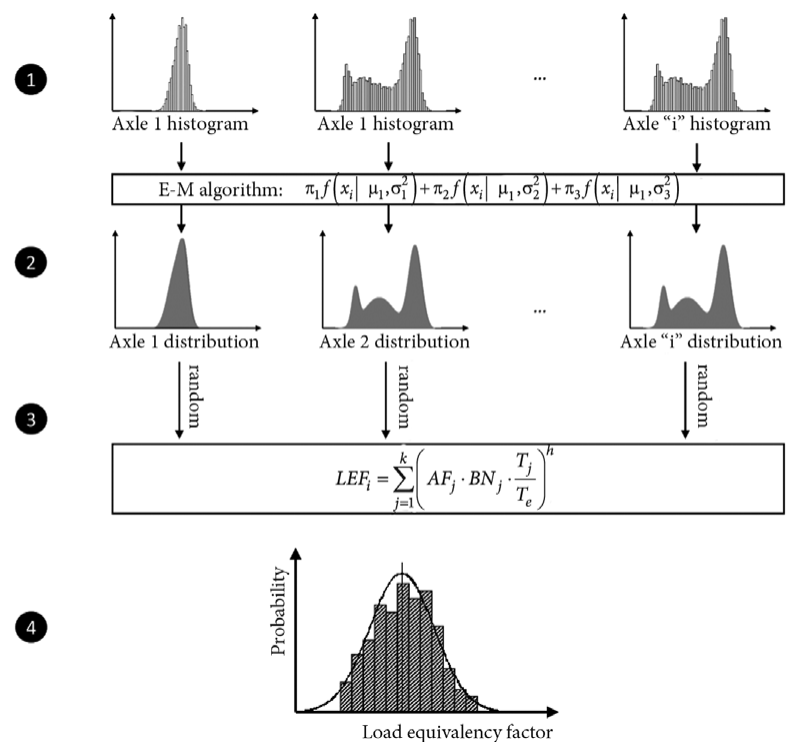
Fig. 4. Calculation of load equivalency factors for given vehicle